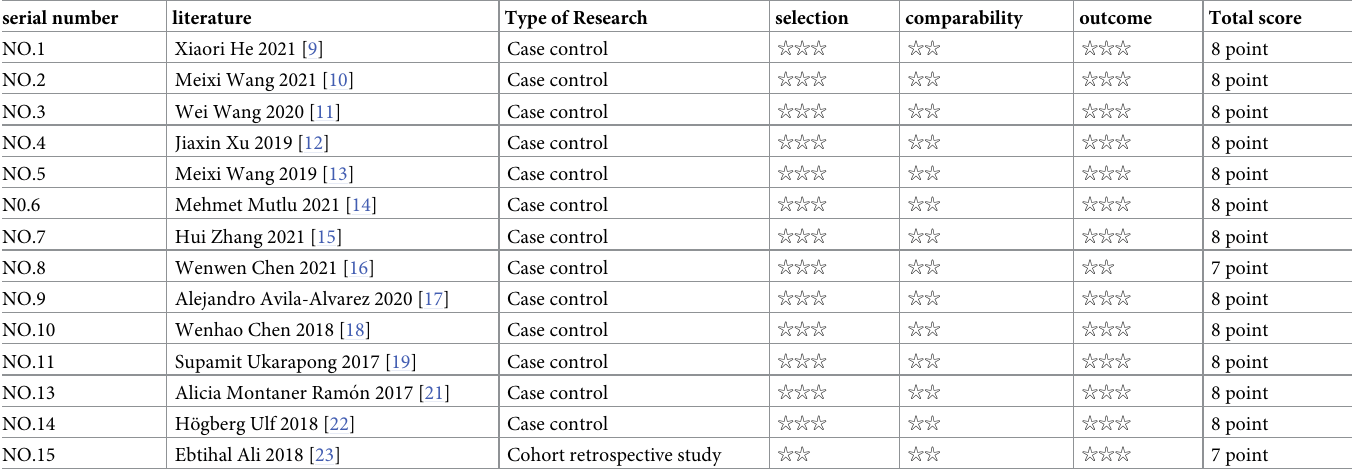
Table 2. Quality evaluation form (NOS scale).